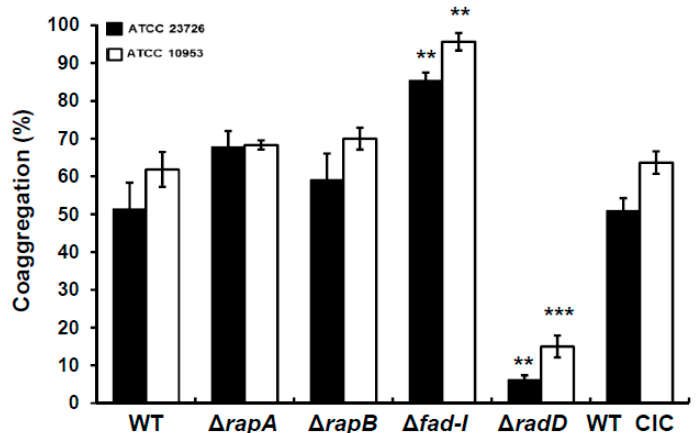
Figure 2. Quantitative Coaggregation of wild-type F. nucleatum ssp. nucleatum (ATCC 23726) and F. nucleatum ssp. polymorphum (ATCC 10953) and their various mutant derivatives: ∆ rapA , ∆ rapB , ∆ fad - I , ∆ radD , and control (WT_CIC) with S. gordonii. Data are represented as mean of percentage coaggregation and standard error of mean of three independent experiments. (** p ≤ 0.01 and *** p ≤ 0.001 compared to the wild-type control).